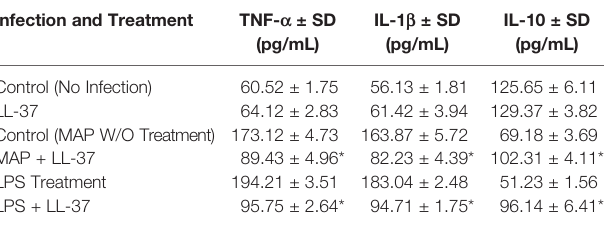
*Indicates P-value of less than